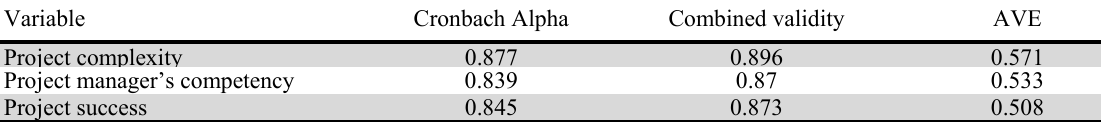
Cronbach's alpha, combined reliability and AVE for the variables studied Variable